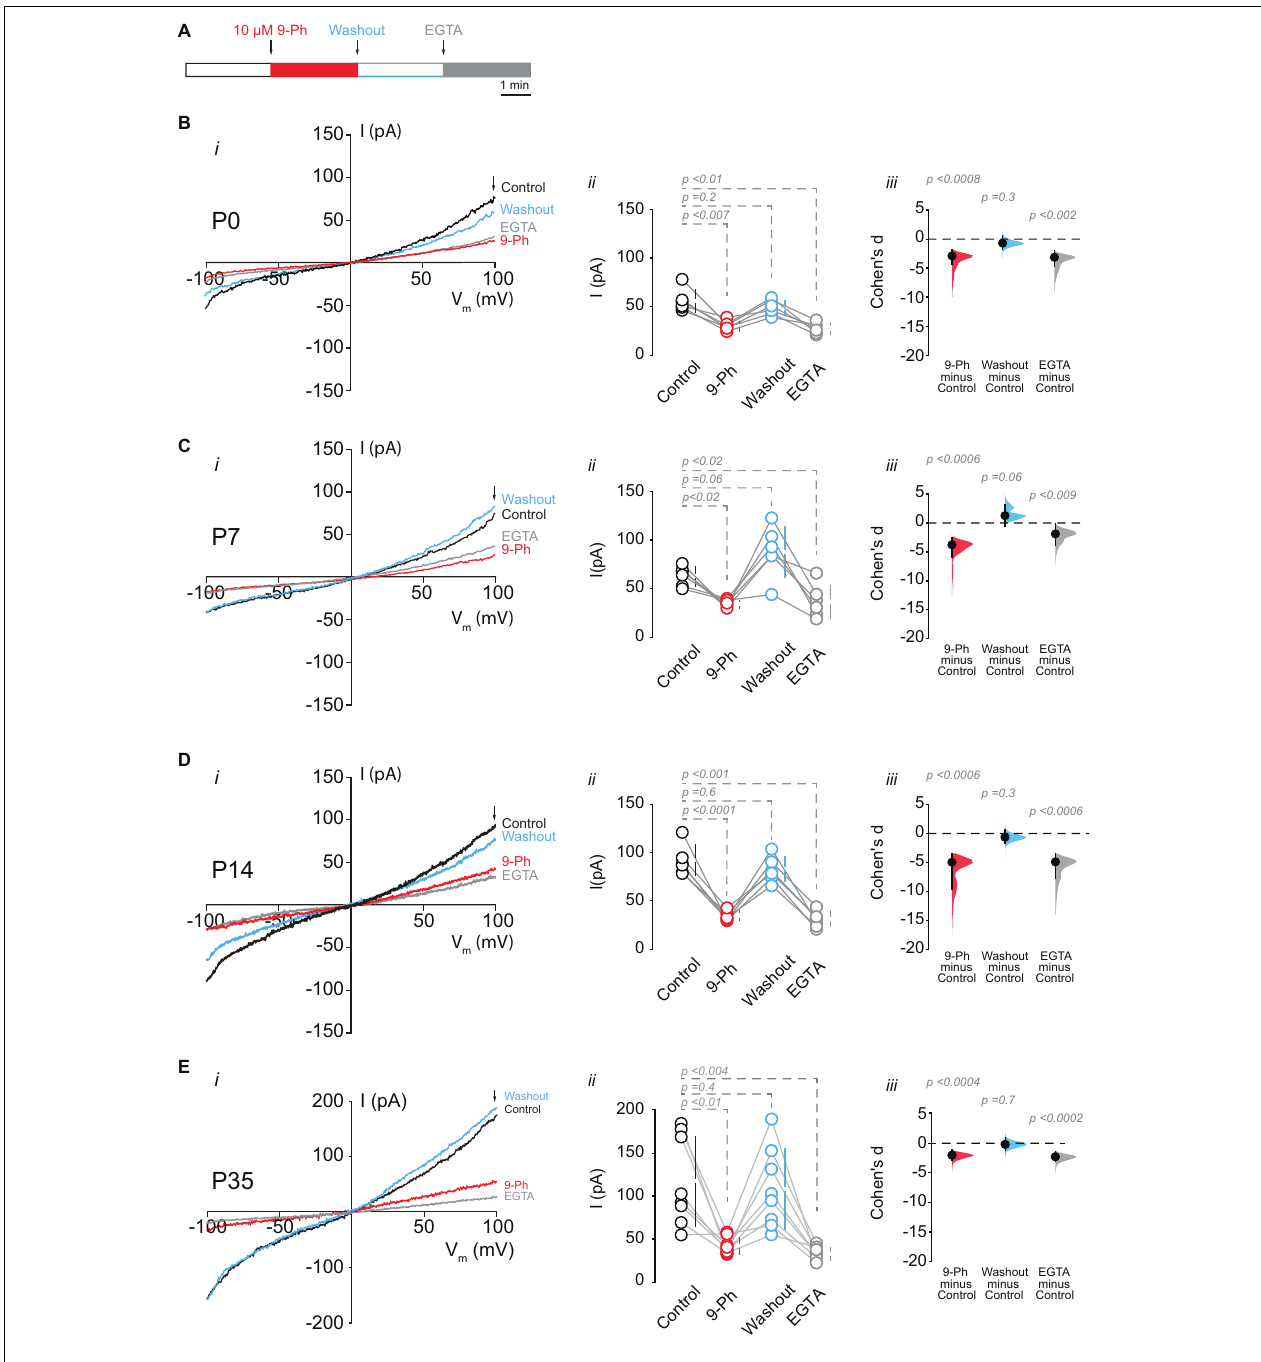
FIGURE 3 | TRPM4 functional expression in CA1 pyramidal neurons during postnatal development. Current recordings in CA1 pyramidal neurons in response to a somatic voltage-ramp ( − 100 to 100 mV from a holding potential of − 70 mV), glutamatergic transmission and action potential generation was inhibited (see section “Methods”). Neurons were recorded in a nystatin-perforated patch configuration (control, 9-Ph and washout) and after breaking the membrane to enter whole cell configuration, which allows EGTA diffusion (EGTA). (A) Diagram of the experimental protocol used in the electrophysiological recordings. (B) Shows the currents recorded at P0 ( n = 6), (C) shows the currents at P7 ( n = 6), (D) shows the currents at P14 ( n = 6), and (E) shows the currents at P35 ( n = 8). ( i ) Each representative current trace was obtained from CA1 pyramidal neurons ( stratum pyramidale ) after different treatments (Control, 9-Ph, Washout, EGTA); arrowhead shows where the current was measured. ( ii ) Summary plot of the current in the different treatments, vertical lines show the 95% CI (statistical difference were determined using a one-way ANOVA, p -values are show above each group). ( iii ) Cohen’s d for 3 comparisons against the shared control. Mean difference is depicted as a dot, the vertical bar shows the 95% CI as indicated by the end of the vertical error bars, and the p -values are shown above each point, depicting results of a two-sided permutation t -test. Each point corresponds to an individual mouse (1 slice per